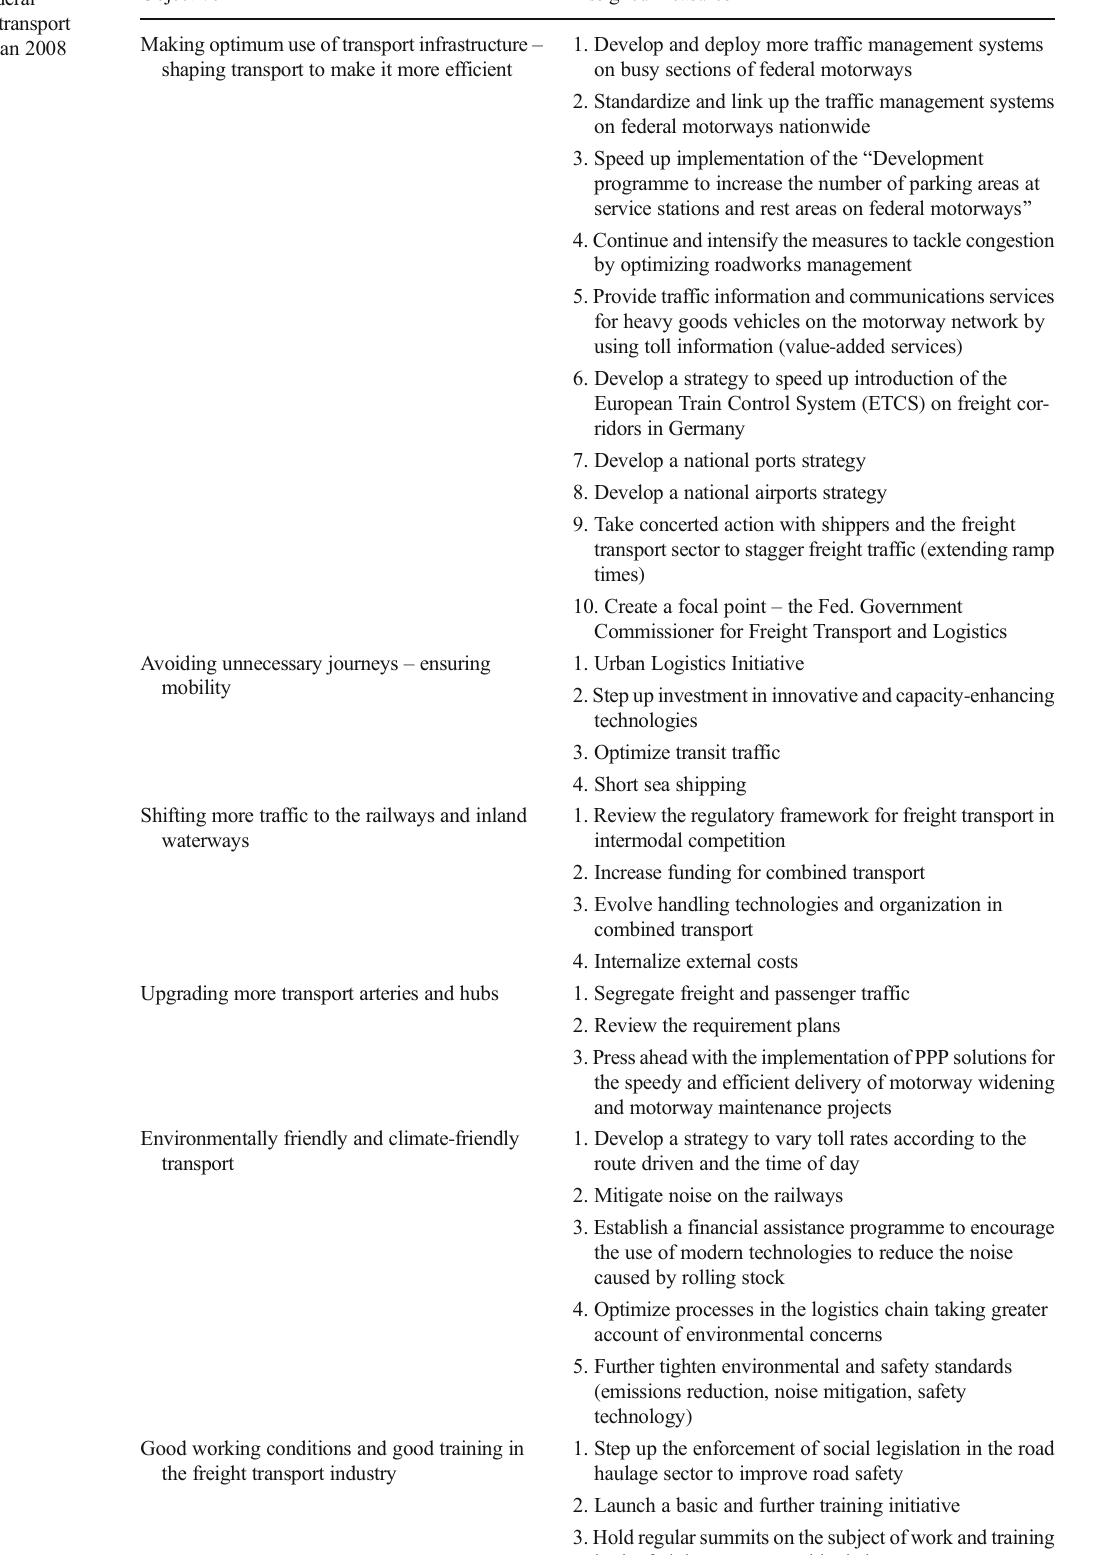
Table 3 Objectives and assigned measures from the federal government ’ s freight transport and logistics masterplan